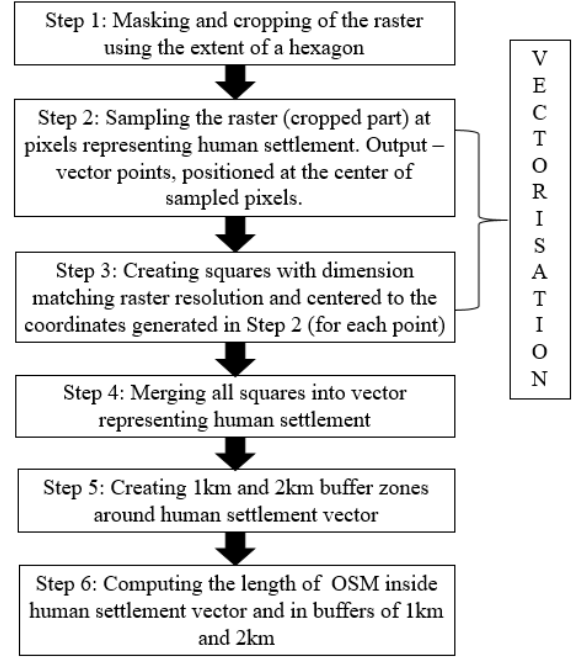
Figure 4. The algorithms